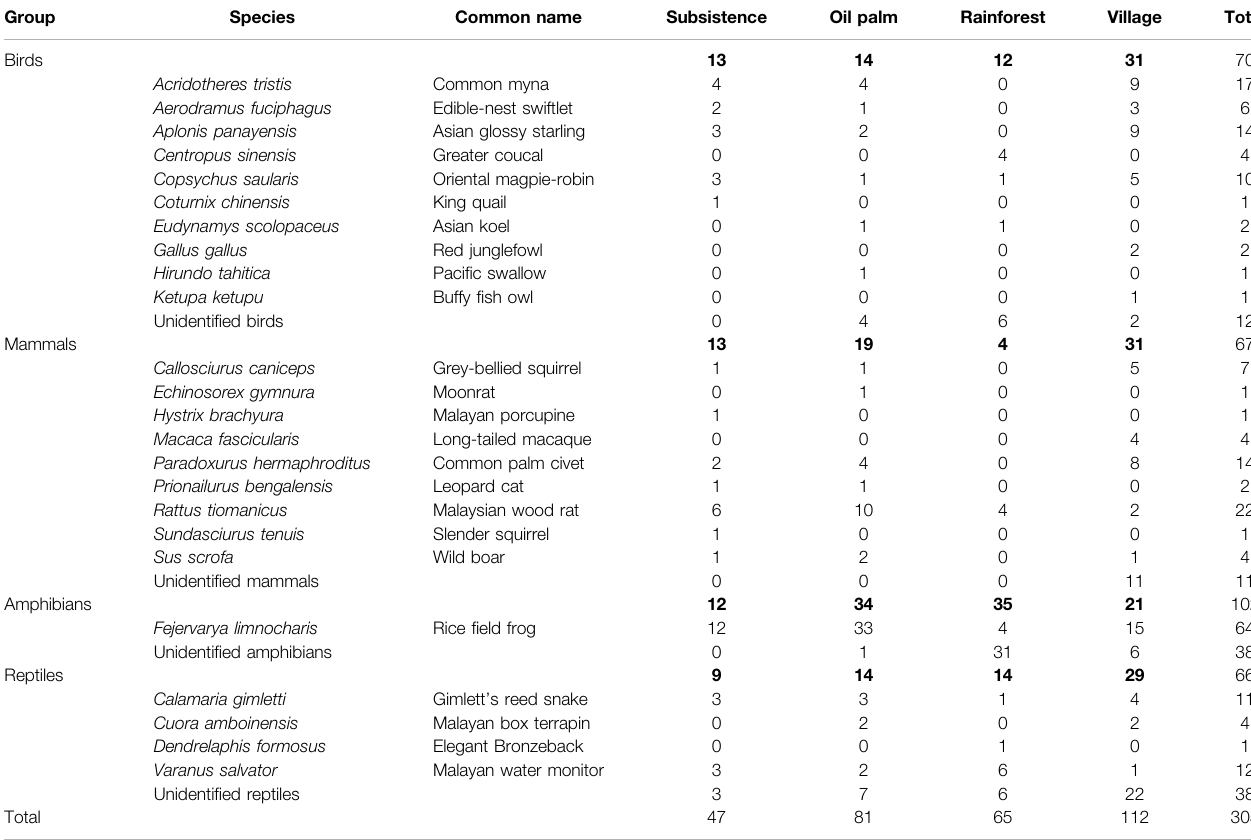
TABLE 1 | Vertebrate roadkills found in the road segments listed by number of individuals per taxonomic group, species, and habitat type. A number of roadkills were unidenti fi able because carcasses were too degraded. Bold values signi fi es “ Total values ” .